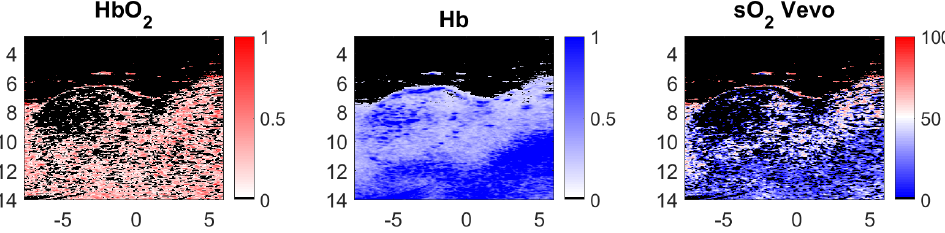
Figure 12. Oxygenated hemoglobin (HbO 2 ) and deoxygenated hemoglobin (Hb) concentration maps and sO 2 map (in %) calculated with the Vevo LAZR concentration maps and Equation (16), from left to right, respectively. The image axes are in